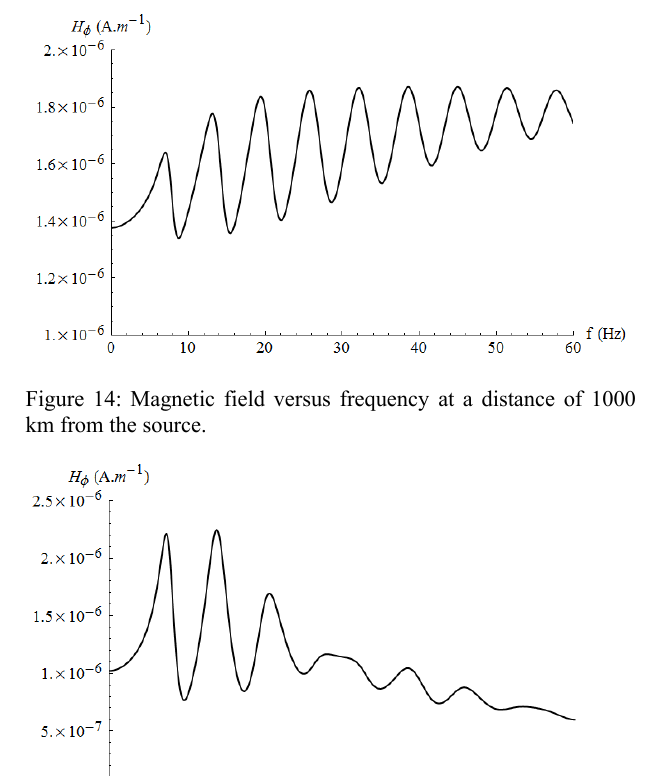
Figure 13: Electric field versus frequency at a distance of 5000 km from the source.